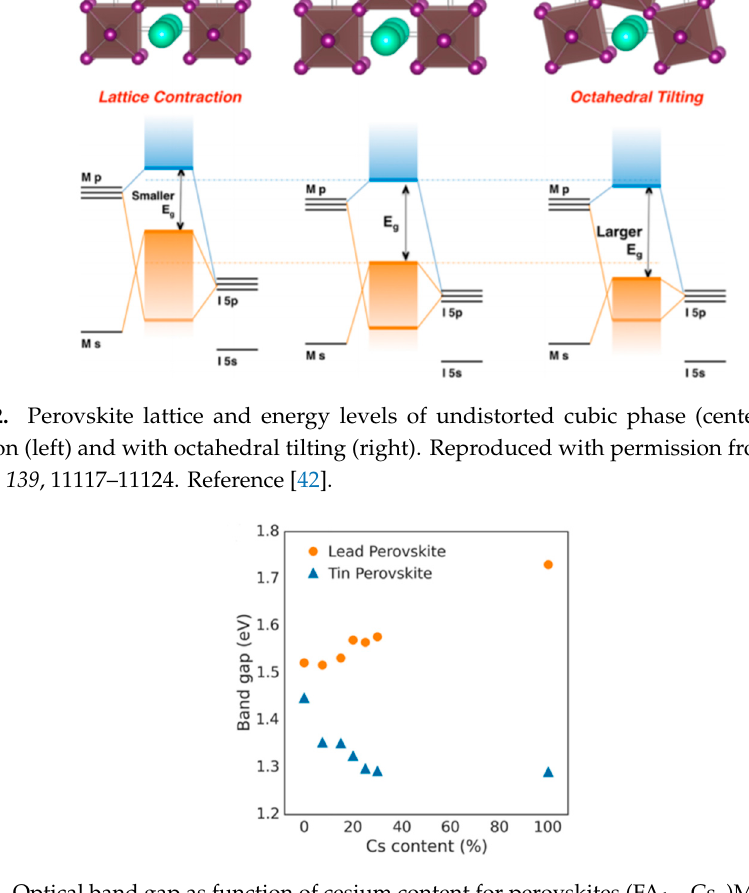
Figure 14. Band gap of MAPbI 3 . The orbital contributions of Pb and I. Reproduced with permission from Chem. Mater. 2016 , 28 , 4259–4266 . Reference [44].